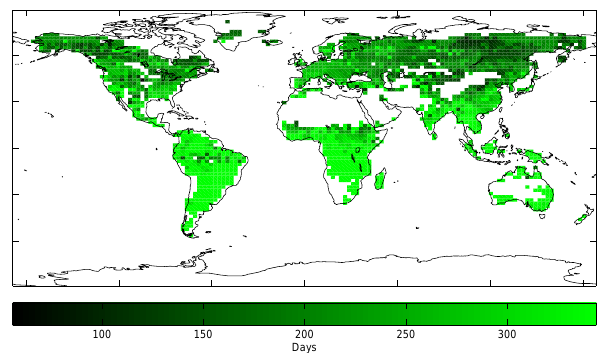
Fig. 10. Length of growing season. All values are calculated for an average LAI for the 2000–2005 study period.